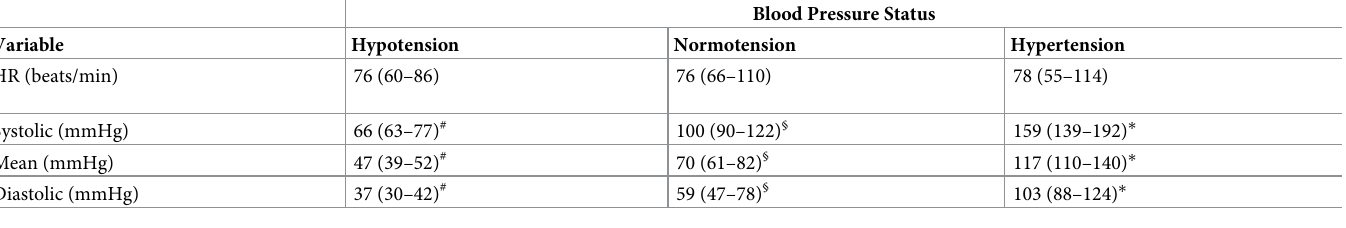
Table 1. Median (min-max) values for heart rate and arterial blood pressure in six, isoflurane anesthetized, mature alpacas during isoflurane induced hypotension, normotension and phenylephrine infusion (0.5–3 mcg/kg/min) induced hypertension. Hypotension was defined as a mean blood pressure between 45 and 55 mmHg, normotension was defined as a mean blood pressure between 65 and 75 mm Hg and hypertension was defined as a mean blood pressure greater than 85 mmHg.